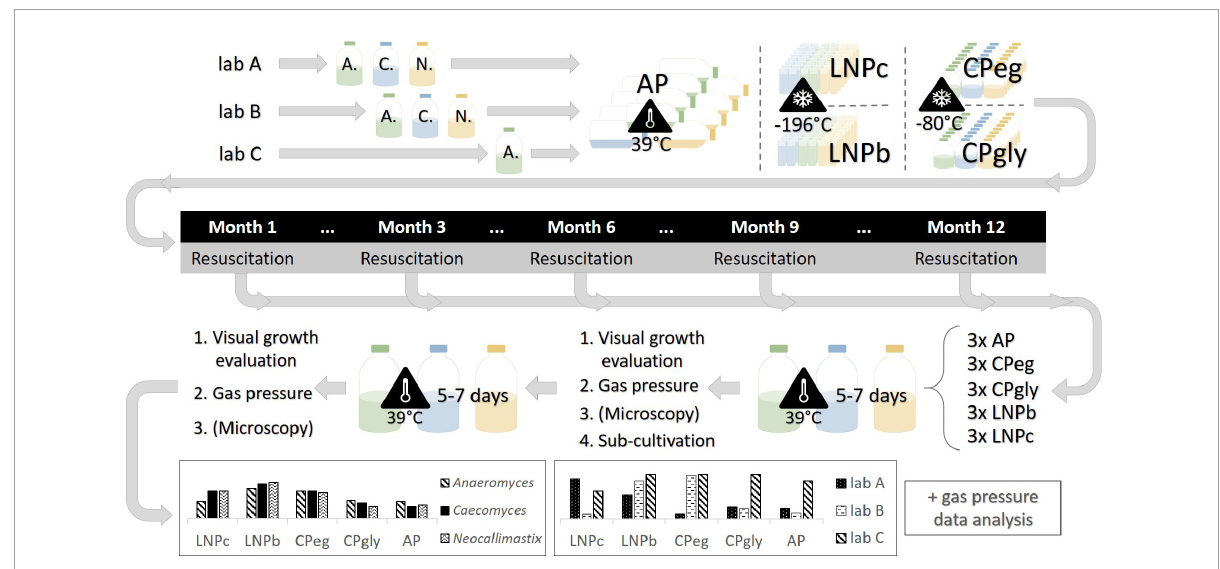
FIGURE1 Experimental design of this study. A ., Anaeromyces mucronatus ; C., Caecomyces sp.; N., Neocallimastix cameroonii . AP, agar preservation protocol; CPeg, cryopreservation protocol with ethylene glycol stock solution; CPgly, cryopreservation protocol with glycerol stock solution; LNPb, preservation of liquid culture with ethylene glycol stock solution in liquid nitrogen; LNPc, preservation of liquid culture with ethylene glycol stock solution in liquid nitrogen.